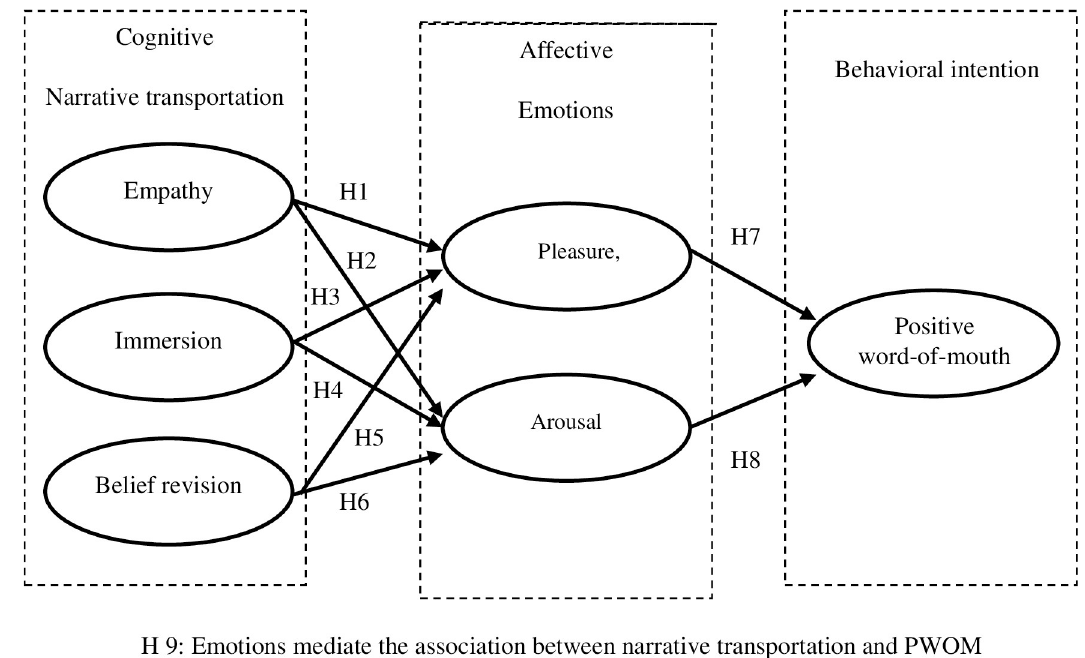
Fig 1. Conceptual research